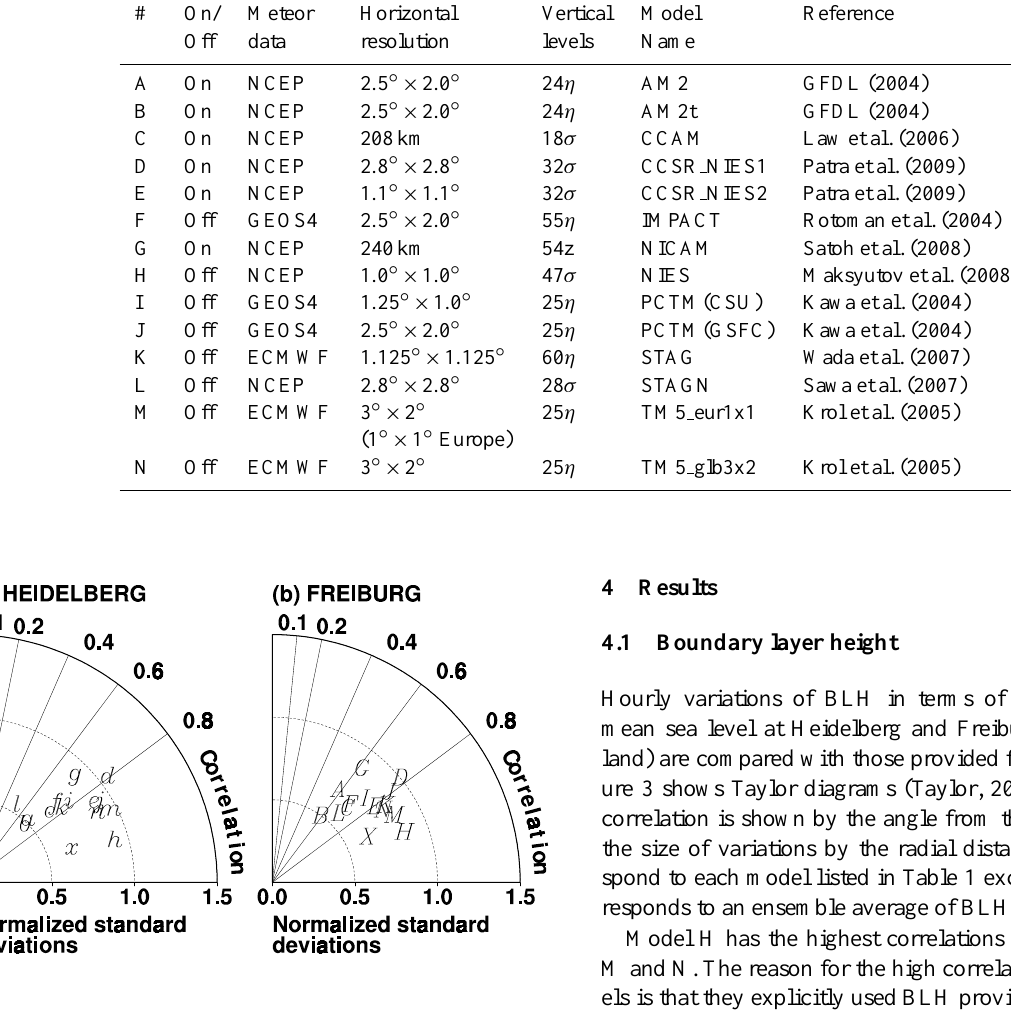
Fig. 3. Taylor diagram for boundary layer height referred to prod- ucts of European Centre for Medium Range Weather Forecasts in Heidelberg (a) and Freiburg (b) . Letters represent each model listed in Table